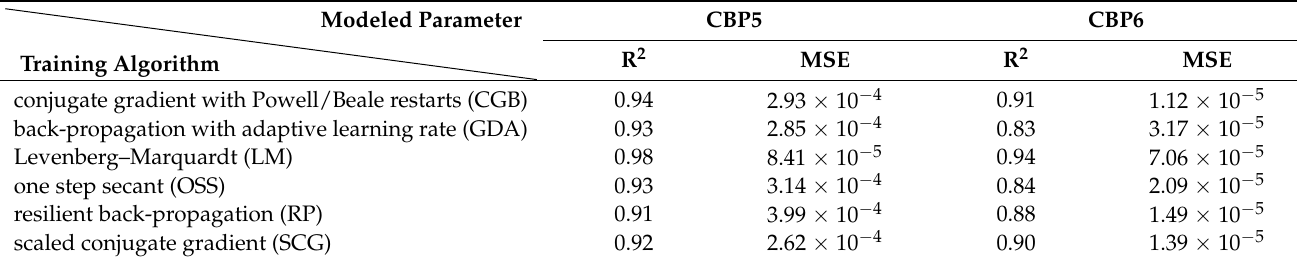
Table 7. Comparison between the performance of various ANN training algorithms for bins 5 and